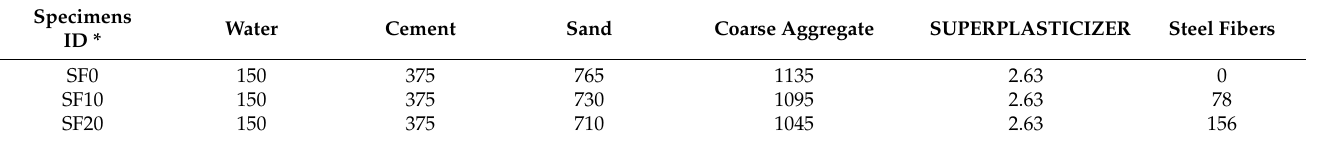
Table 4. Mixture proportions of concrete (kg/m 3